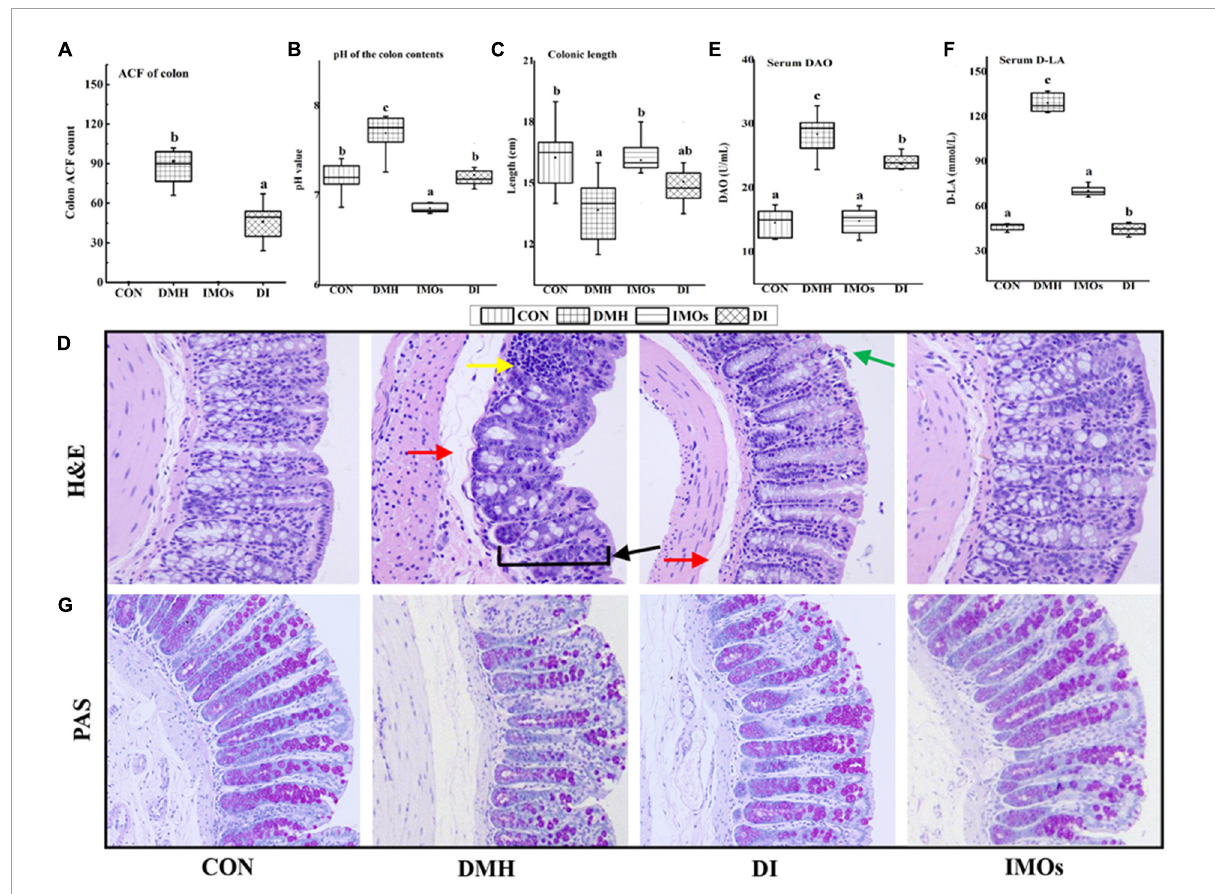
FIGURE3 (A) Colon ACF counts among rats in the four groups. (B) Effect of IMOs treatment on pH of colonic contents in rats. (C) Effect of IMOs treatment on colon length in rats. (D) H&E staining of colonic tissue from rats (200 × magnification). Effect of IMOs treatment on intestinal permeability in DMH-treated rats. The levels of (E) DAO and (F) D-LA in rat serum and (G) PAS staining of colonic tissue from rats (200 × magnification). Values followed by different letters (a, b and c) in each group are significantly different ( p <